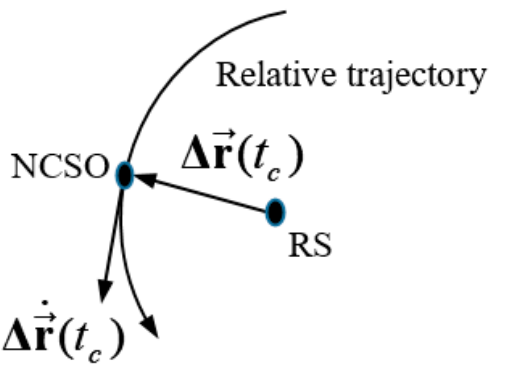
. → →   r ( t c ) vector and relative velocity vector ∆ r ( t c ) are perpendicular in a  Δ r t Δ r vector and relative velocity vector ( ) c t are c t . c